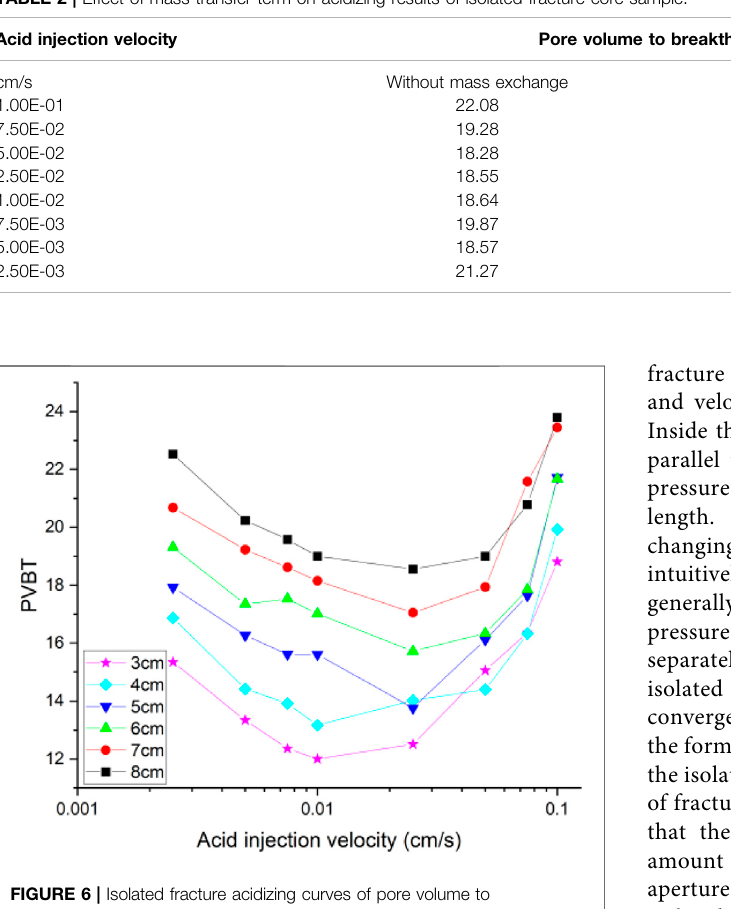
Frontiers in Earth Science |